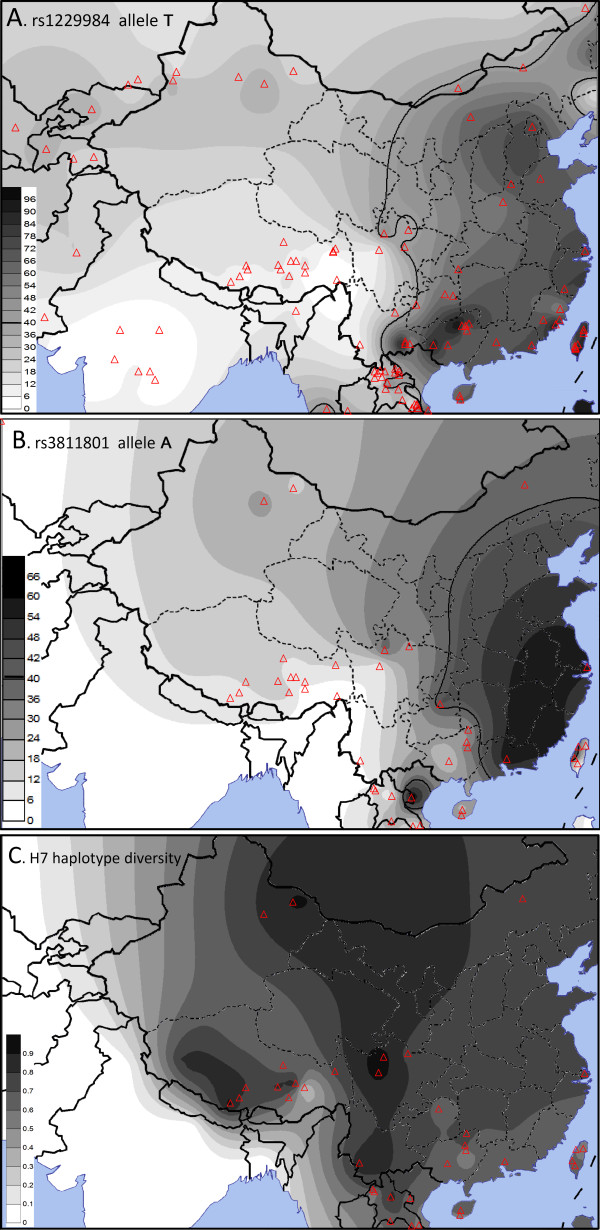
Geographic distributions ofADH1B*48His(rs1229984*T) and rs3811801*A andADH1BH7 haplotype diversity in eastern Asia.